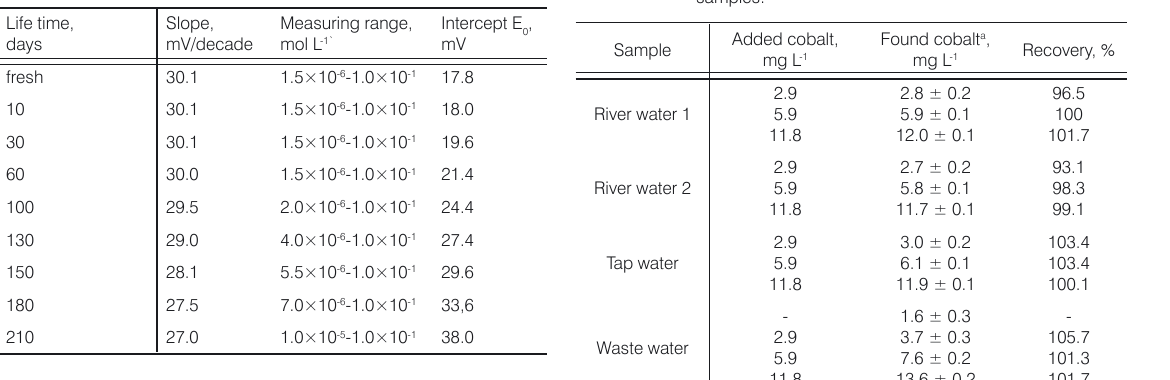
Table 2. Effect of life-time on the properties of proposed sensor no 2.